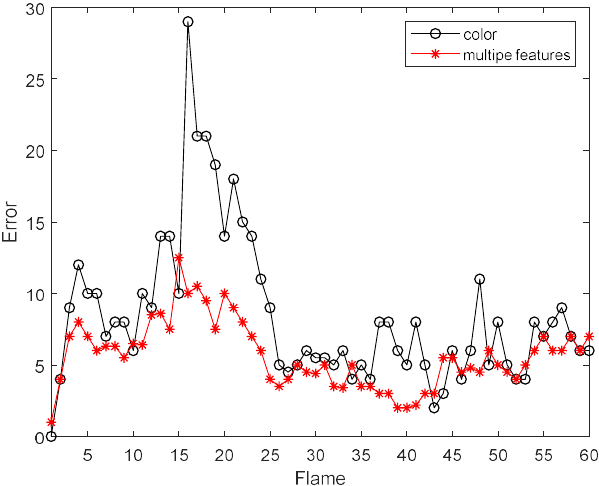
Figure 17. The RMSE comparison corresponding to background change.